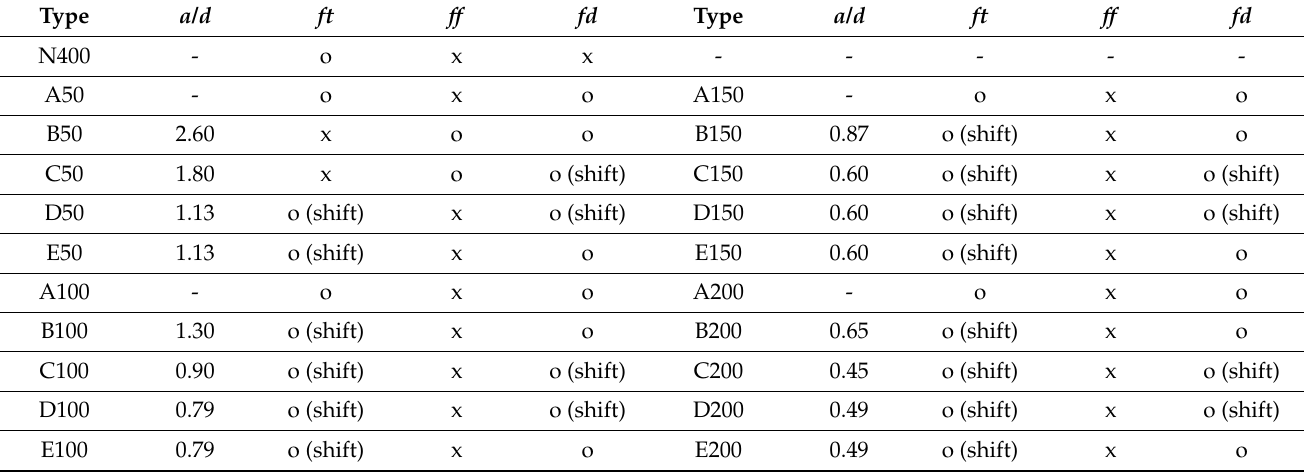
Table 1. Summary of the three theoretically possible modes and a/d results.